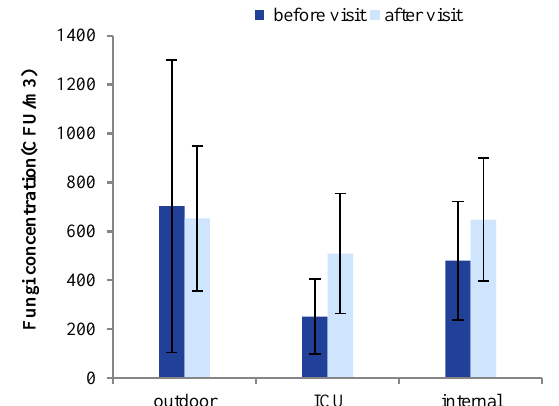
Figure 2. The variation patterns of airborne fungi density at two sampling